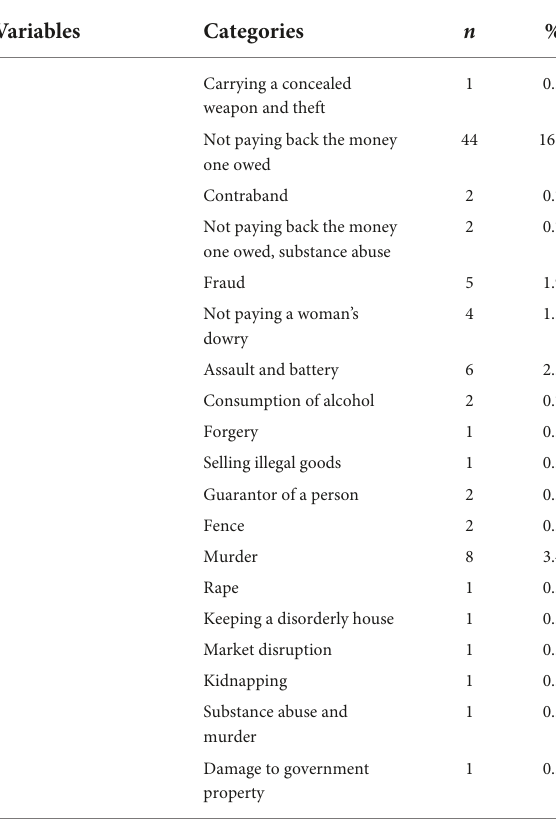
TABLE 1 Demographic information of male prisoners ( n =